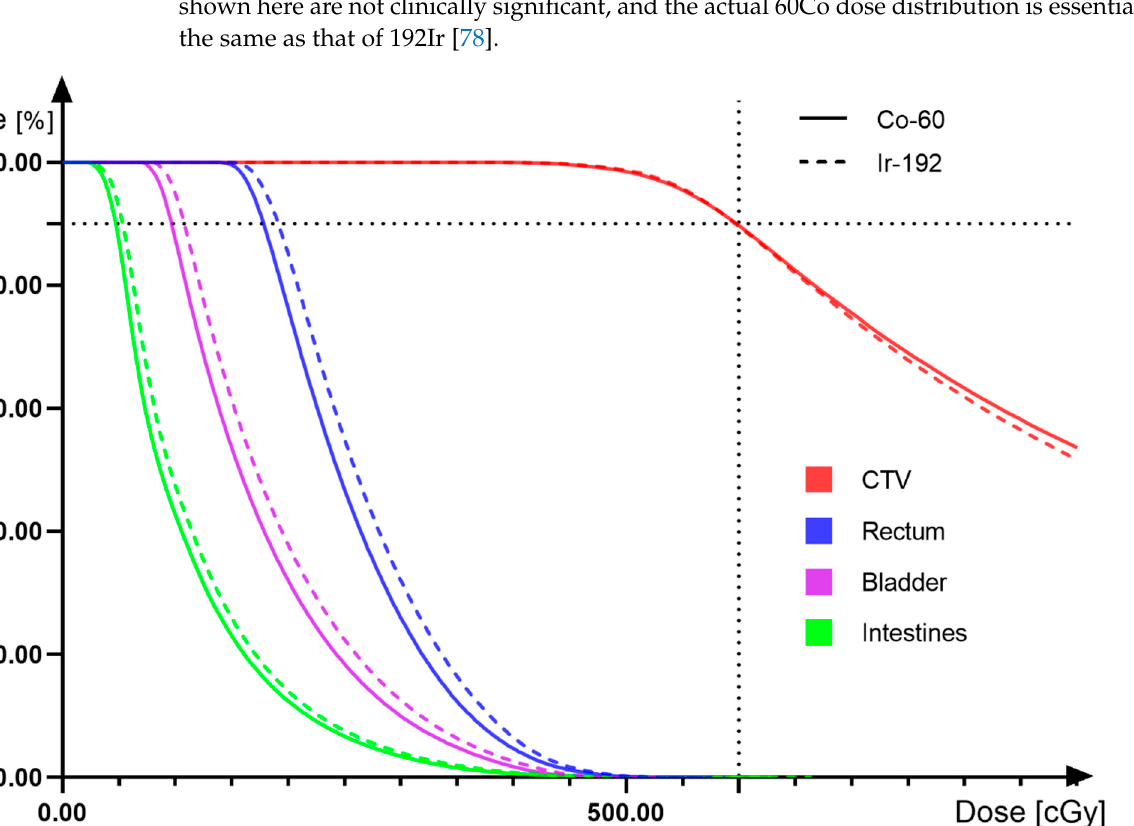
Table 1. Mean physical doses for CTV and OARs ( 𝑋(cid:3364) (cid:3397) 𝑆 ).